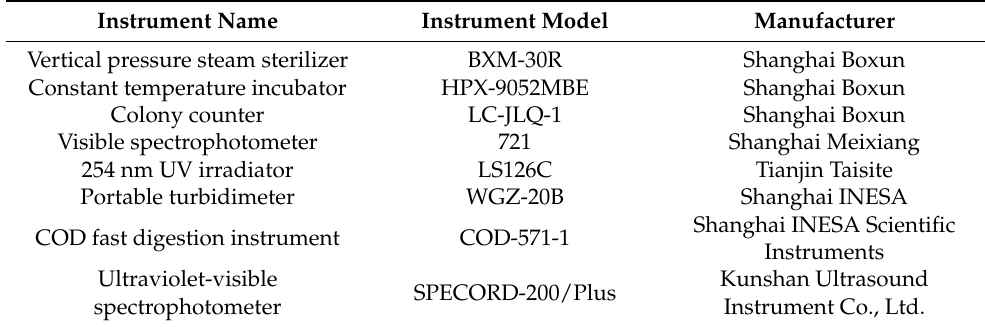
Figure 1. Quasi-parallel beam instrument. 1. Low-pressure UV lamp; 2. Parallel beam cylinder; 3. Quasi-parallel UV light; 4. Adjustable bracket; 5. Magnetic stirrer; 6. Aluminum plate; 7. Petri dish. Table 4. Experimental instruments.